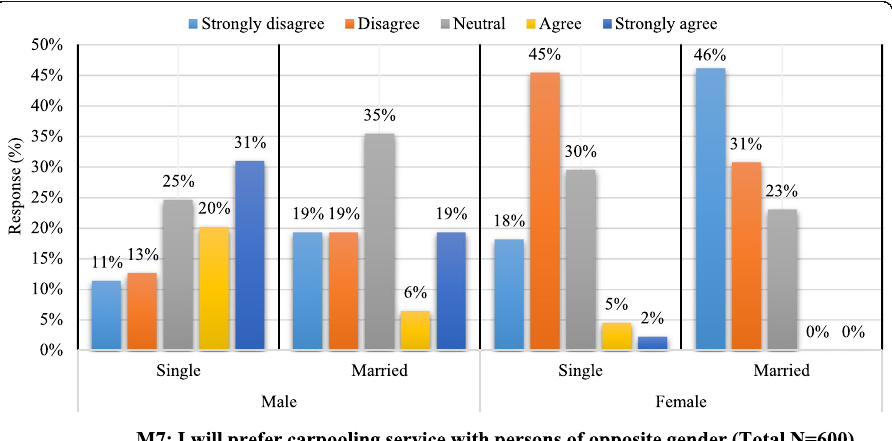
Fig. 7 Willingness of respondents to travel with opposite gender partners (M7) in accordance with